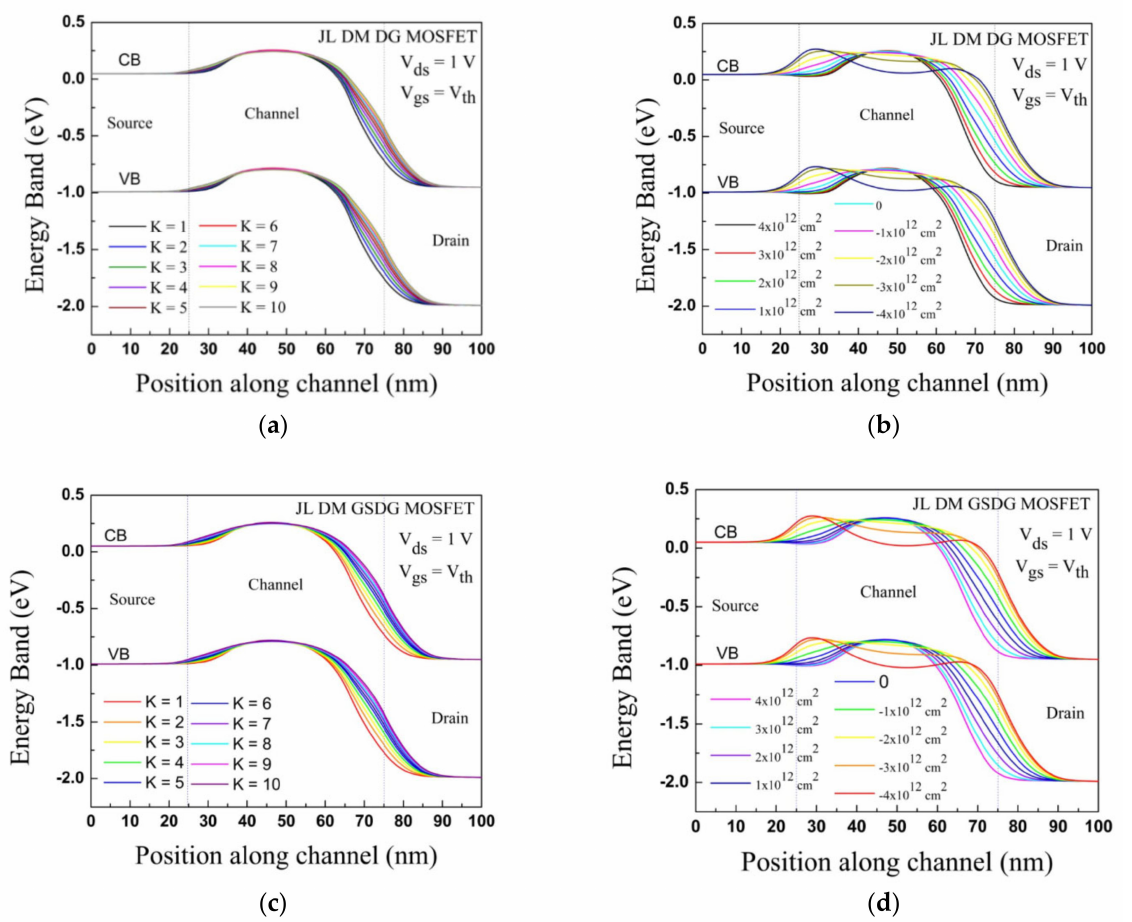
Figure 7. Plot of the energy band diagram for JL-DM-DG-MOSFET and JL-DM-GSDG-MOSFET at V gs = V th : ( a , c ) neutral biomolecules; ( b , d ) charged